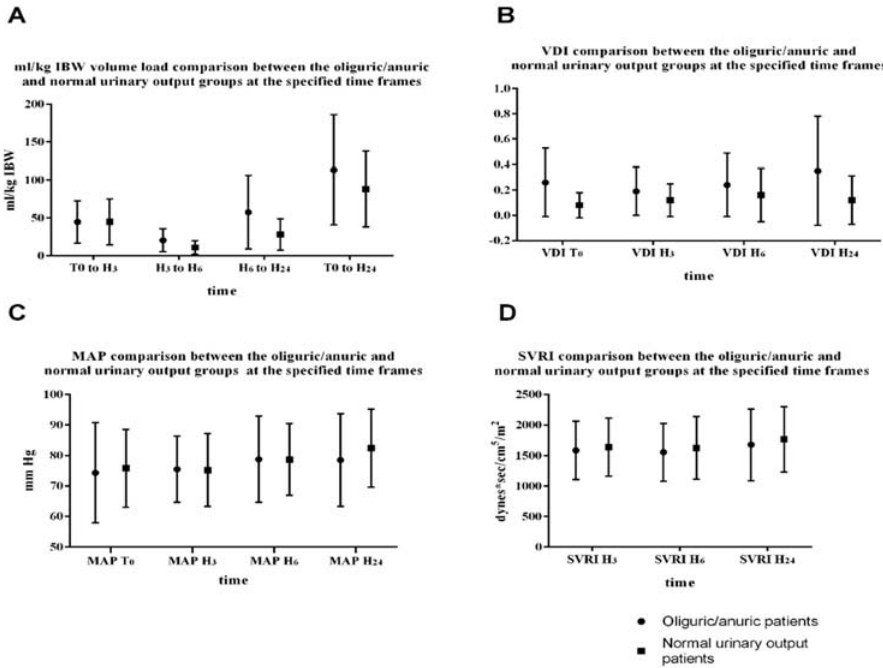
Figure 2. Comparison between the poor and normal urinary output groups at the specified time frames. ( A ) Fluid load, ( B ) vasopressor dependency index, ( C ) mean arterial blood pressure, ( D ) systemic vascular resistance index.